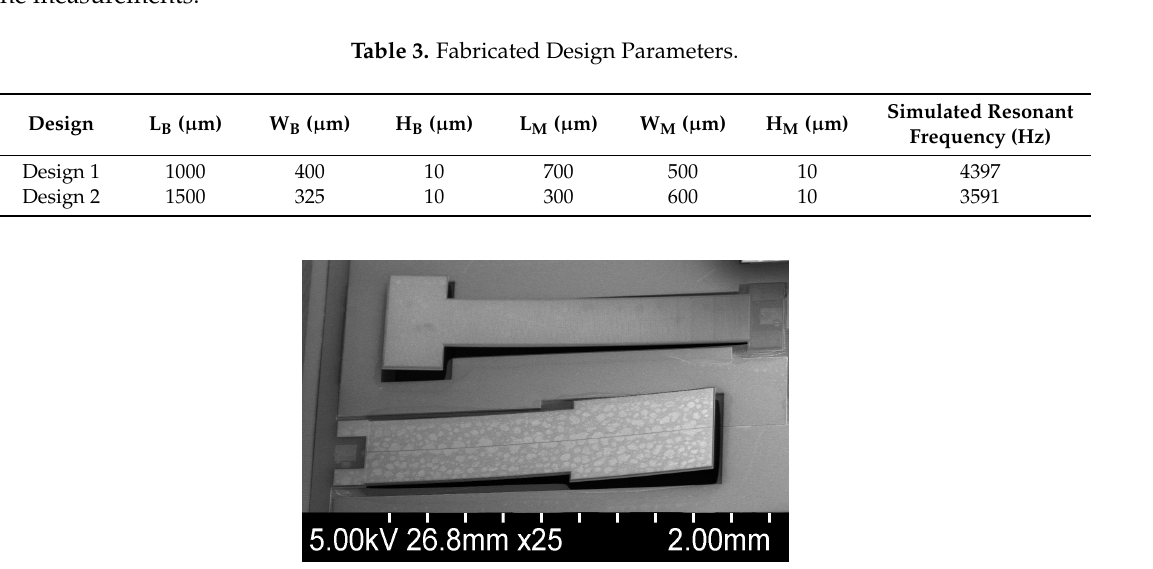
Table 3. Fabricated Design Parameters.